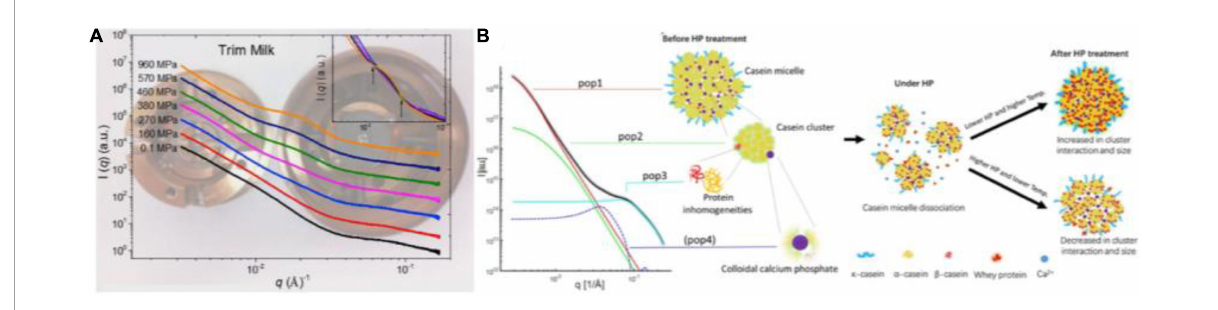
FIGURE5 (A) In situ synchrotron small-angle X-ray scattering (SAXS) patterns of trim milk under different HHP using DAC (92) (Copyright 2018 Elsevier Publisher). (B) Graphic representation of the four contributions of CNs model at different length scales and structural dynamics during HHP from in situ SAXS, based on Yang et al. (84) (Copyright 2021 Elsevier Publisher).